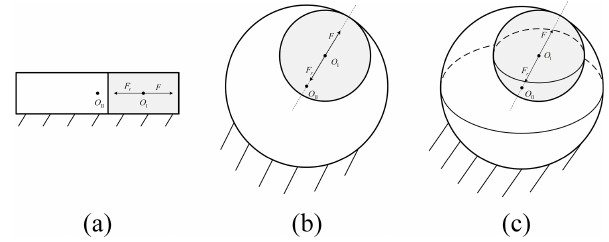
Figure 4. State jump analysis